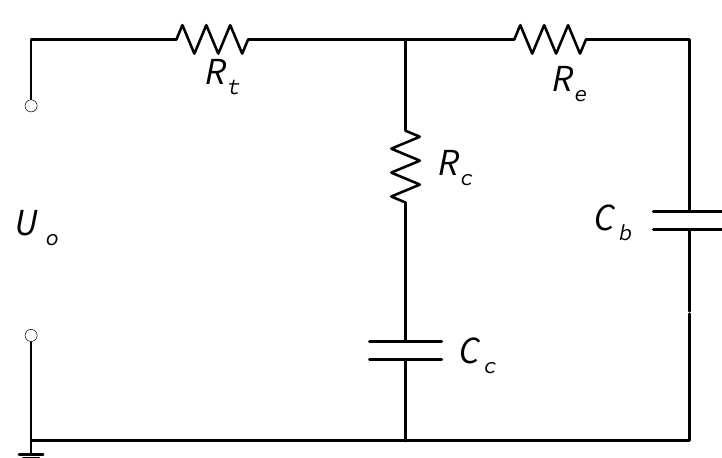
Figure 1. Schematic of RC battery